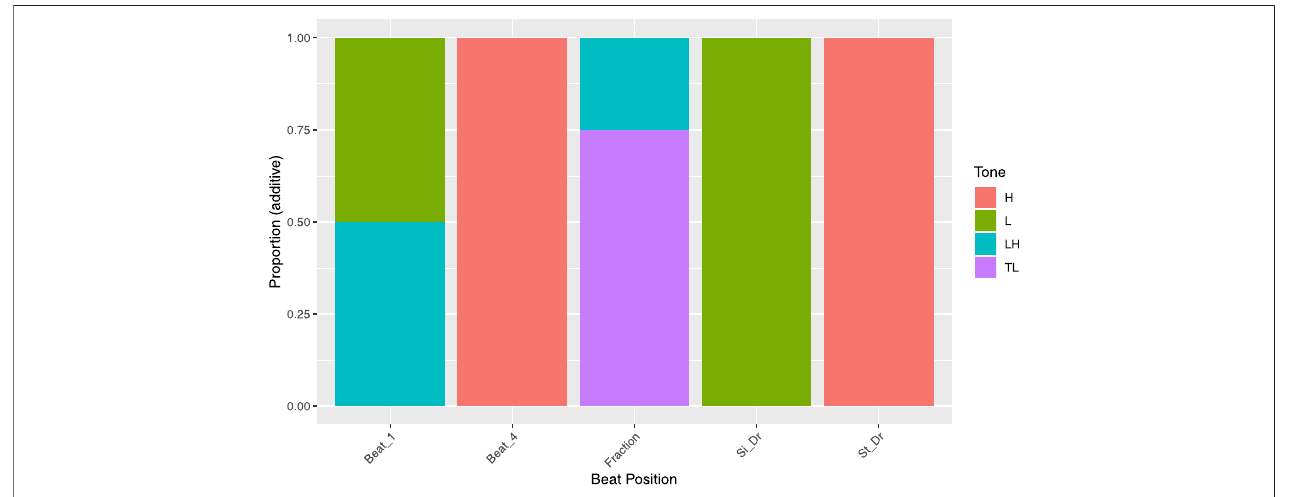
FIGURE 9 | Alignment of syllables by tone in the opening lines/chorus of Song 1 represented as proportions of occurrences.